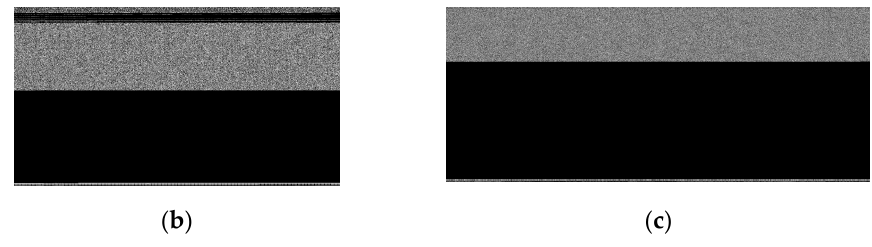
Figure 7. Malware sample image. ( a ) Vundo family. ( b ) Simda family. ( c ) Tracur family